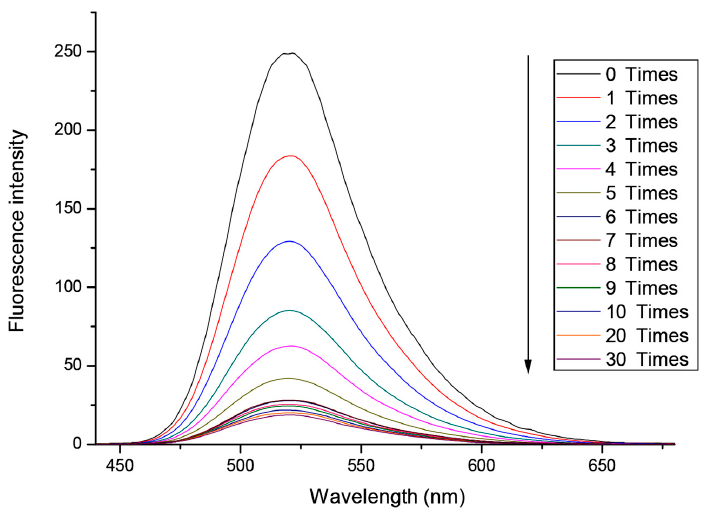
Figure 5. Changes in the fluorescence spectra of compound L (10 μ M) in EtOH/H 2 O (4:1 v/v ) as a function of added [Cu 2+ ].